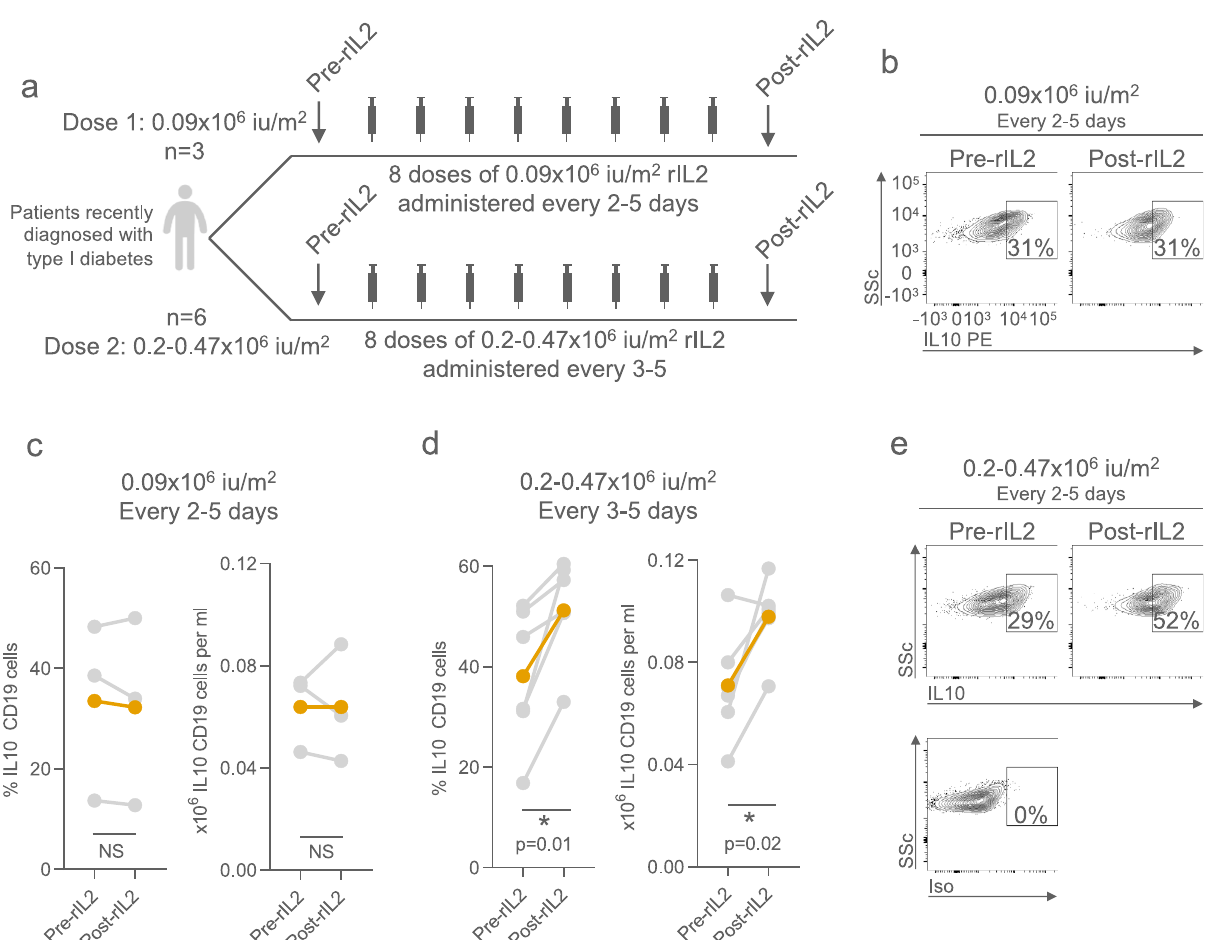
Fig. 2 | Analysis of B cells and plasma cells from patients given LD IL-2 treat- ment. a Diagrammatic schema summarizing the two treatment arms of the LD aldesleukin study. Patients with recently-diagnosed type 1 diabetes received 0.09×10 6 IU/m 2 or 0.2 – 0.47×10 6 IU/m 2 aldesleukin every two to fi ve days. Pro- portion (of total B cells) or absolute number of IL-10-positive B cells in patients prior to and following the administration of 0.09×10 6 IU/m 2 ( c ) or